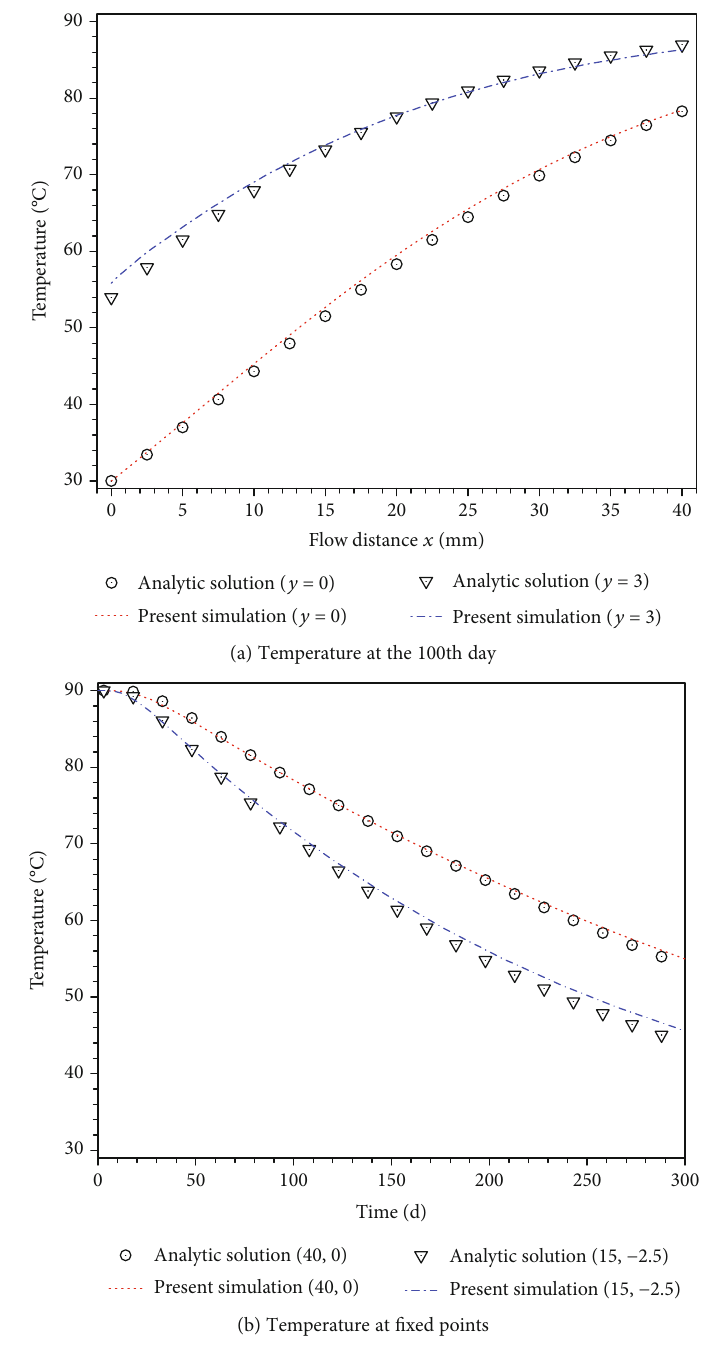
Figure 4: Comparison between analytical solution and present